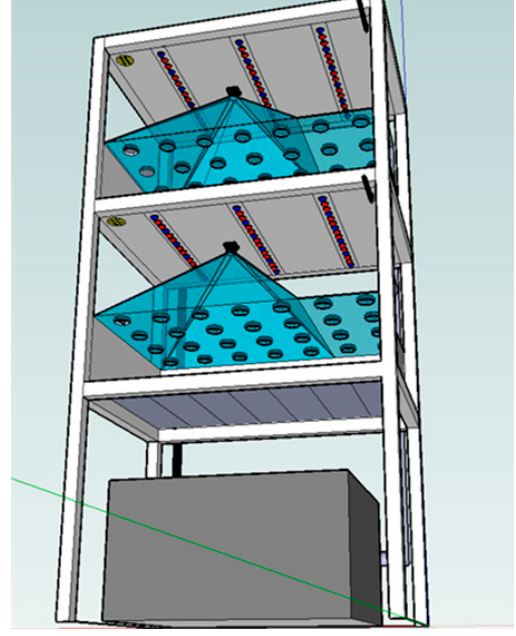
Figure 6. The experimental crop culture bed.